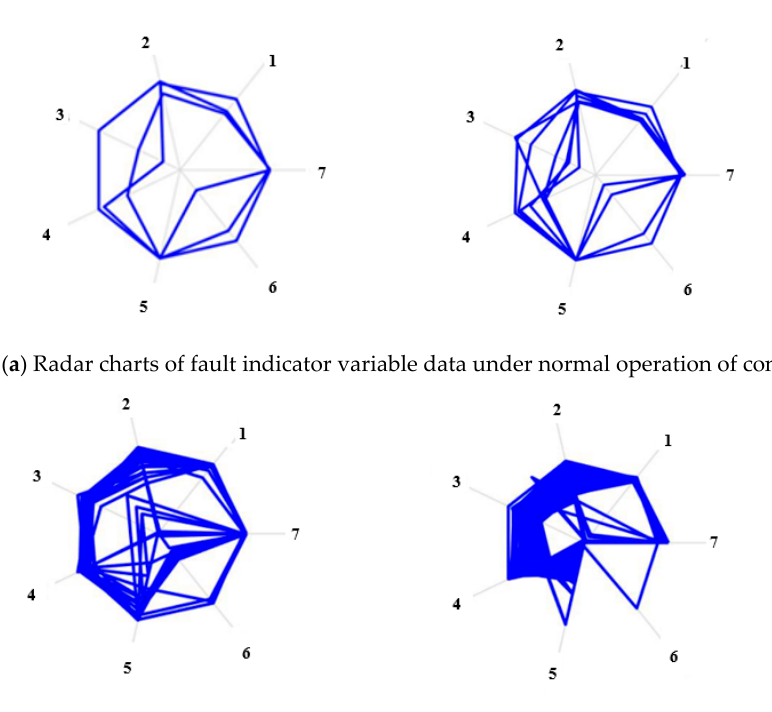
Figure 3. Radar charts covering the fault features. ( 1 ) Wind speed; ( 2 ) turbine rotor position; ( 3 ) active power; ( 4 ) reactive power; ( 5 ) generator rotor speed; ( 6 ) grid side converter voltage; ( 7 ) generator torque set-point.